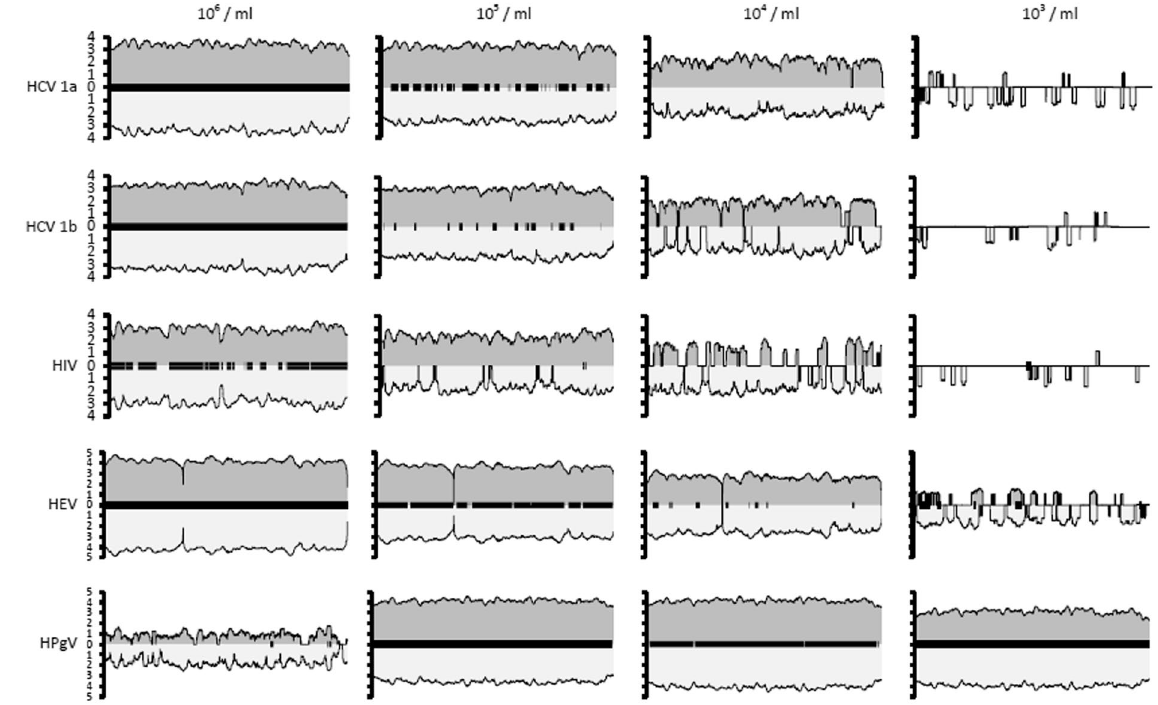
Figure 1. Coverage plots of the Blood Borne Virus Panel samples. The x-axes represent scaled virus genomes, and log 10 coverages are given on the y-axes. ‘A’ samples are plotted above the axis, ‘B’ samples below. Solid and broken black bars along the x-axes represent where virus coverage of the corresponding ‘Untreated’ sample is ≥ 10.